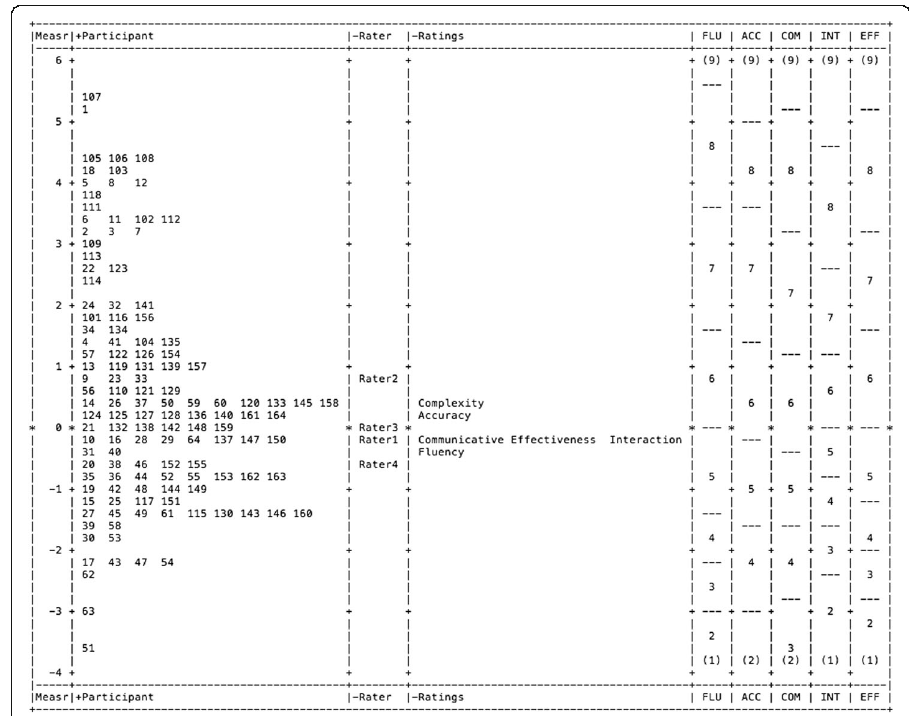
Fig. 1 The variable map of the MFRM analysis of the initial 9-point rating scales. FLU = Fluency, ACC = Accuracy, COM = Complexity, INT = Interaction, and EFF = Communicative